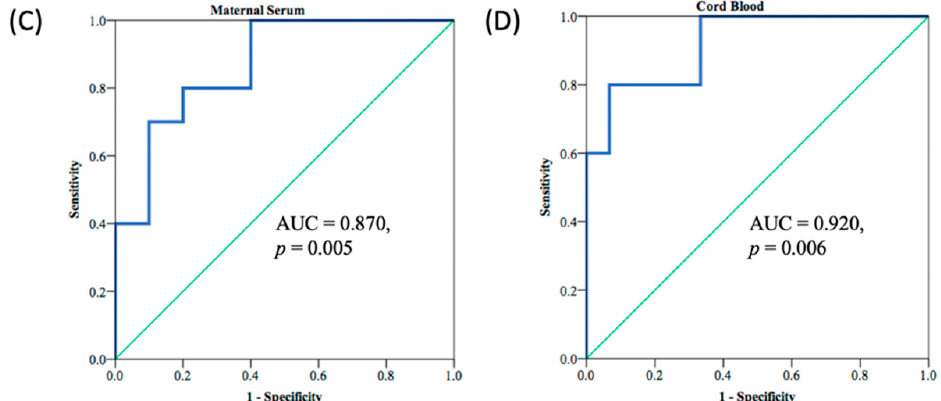
Figure A1. ( A ) ROC curve of S1RBD in maternal serum by the immunoassay/spectrum analyzer for Nab inhibition rate ≧ 30% for Delta-type SARS-CoV-2. ( B ) ROC curve of S1RBD in neonatal cord blood by the immunoassay/spectrum analyzer for Nab inhibition rate ≧ 30% for Delta-type SARS-CoV-2. ( C ) ROC curve of S1RBD in maternal serum by the immunoassay/spectrum analyzer for Nab inhibition rate ≧ 70% for Delta-type SARS-CoV-2. ( D ) ROC curve of S1RBD in neonatal cord blood by the immunoassay/spectrum analyzer for Nab inhibition rate ≧ 70% for Delta-type SARS-CoV-2. ROC curve, receiver operating characteristic curve; SRBD, spike protein receptor binding domain; AUC, area under curve.